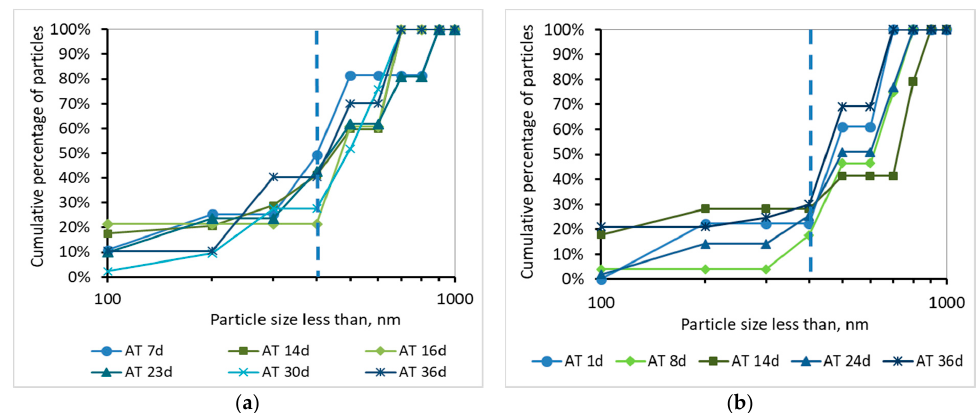
Figure 9. Cumulative percentage of particles smaller than 1000 nm for a sample from the aeration tank ( ΑΤ ) as a function of MBR operation time ( a ) for synthetic versus ( b ) domestic wastewater.